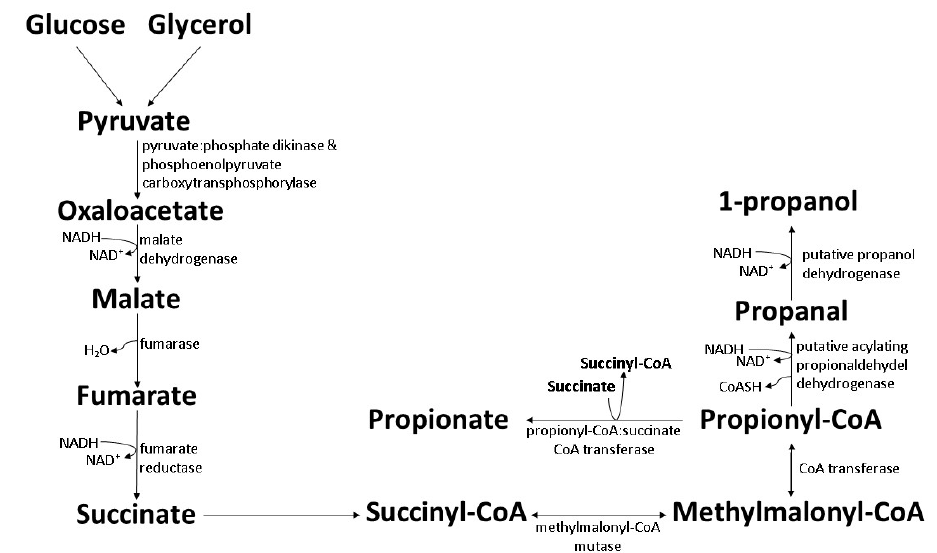
Figure 5. Biosynthesis of 1-propanol by wild-type Propionibacteria through the Wood–Werkman pathway [103,104].